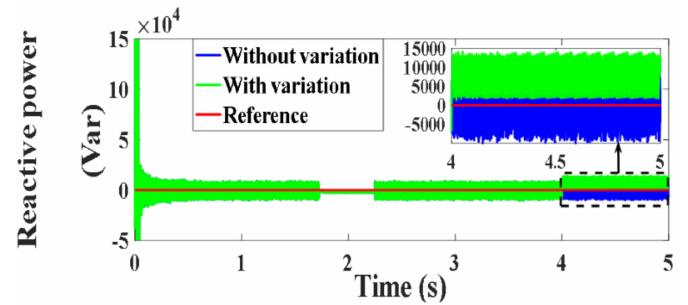
Figure 176. Reactive power under PVC